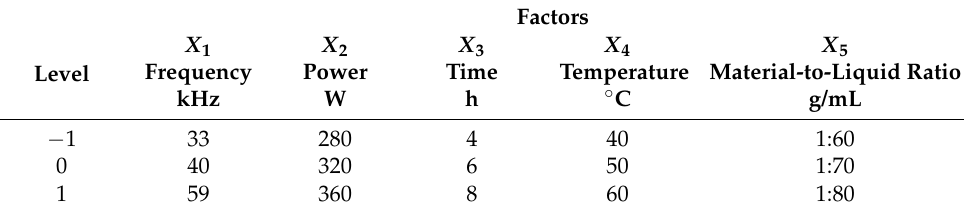
Table 1. Codes and levels of independent variables for response surface analysis during ultrasonication.